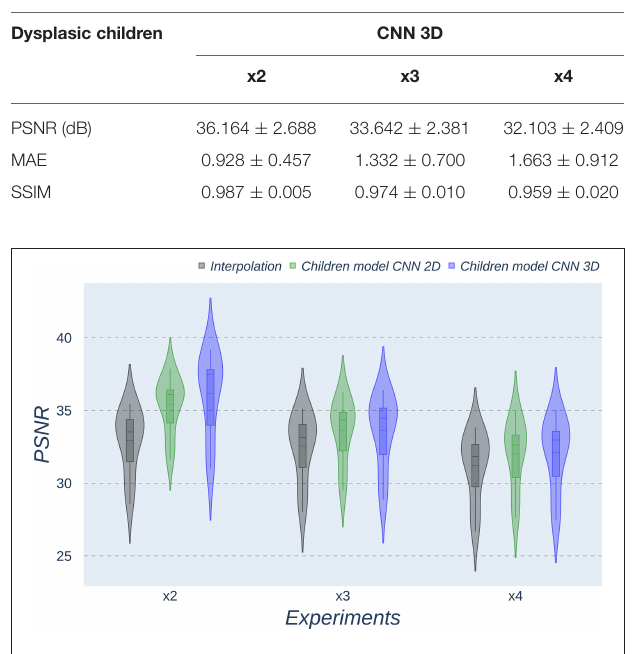
FIGURE 7 | Violin plots for PSNR metric comparing the different methods at the distinct scaling factors. Each violin plot corresponds to one specific experiment, and it is calculated from dysplasic patients.